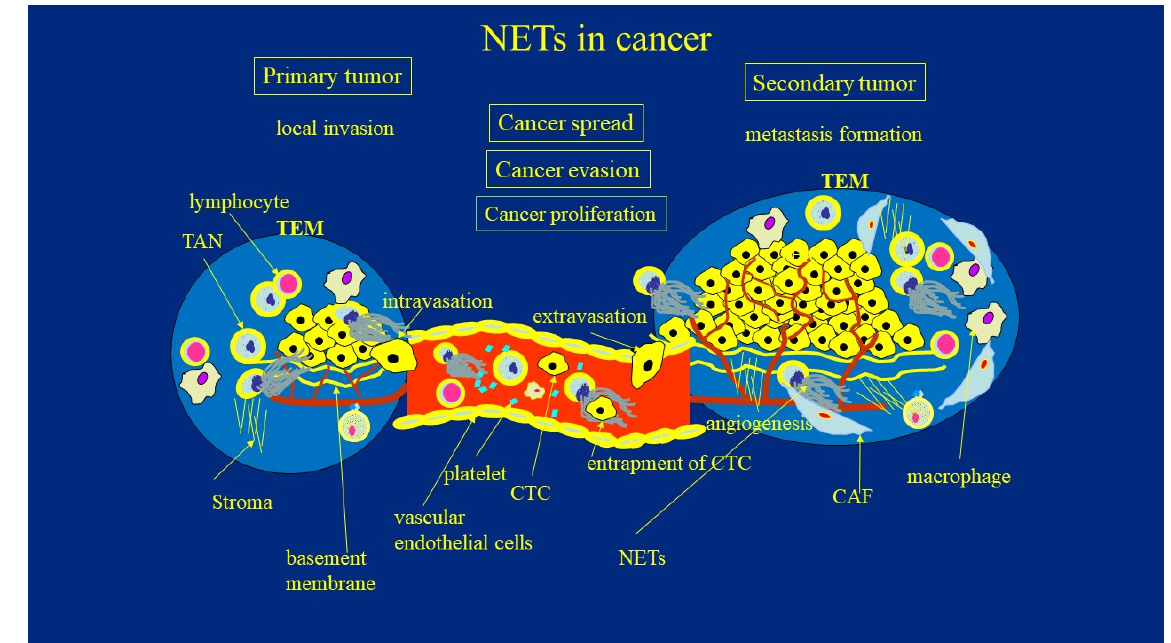
Figure 1. The role of NETs in cancer development. TAN—tumor associate neutrophils; TEM—tumor environment; CAF—cancer associated fibroblasts; NETs—neutrophil extracellular traps; CTC—circulating tumor cells.